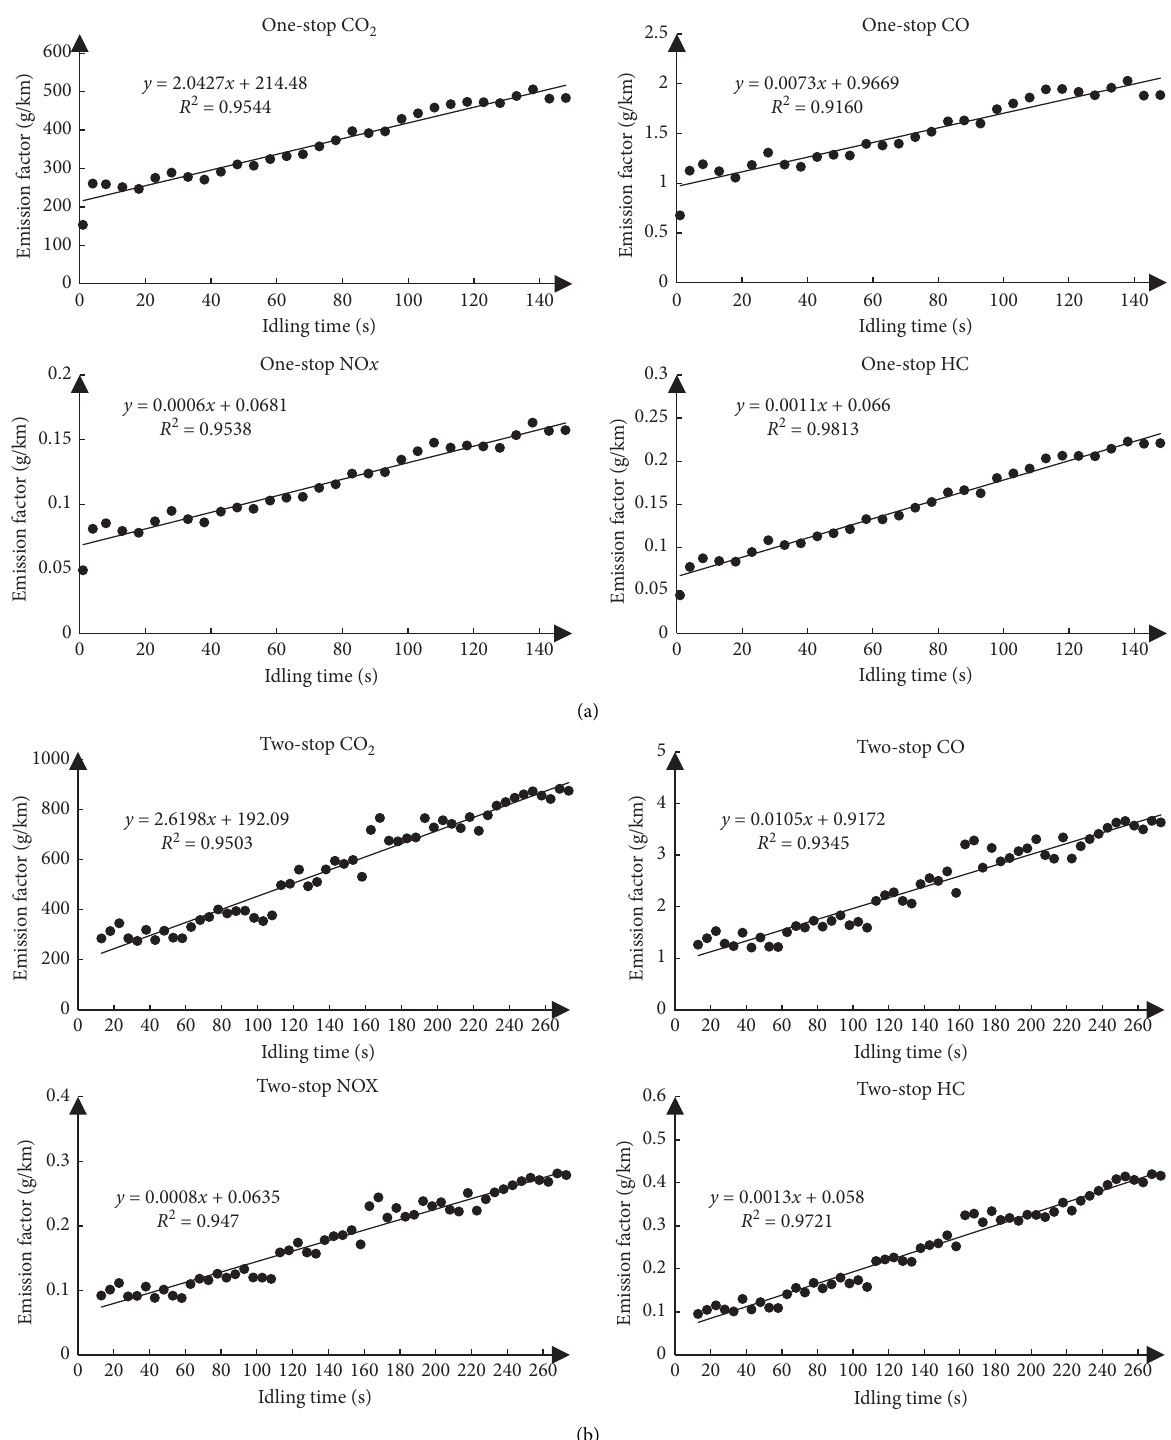
Figure 9: Emission factor model based on the number of stops and idling